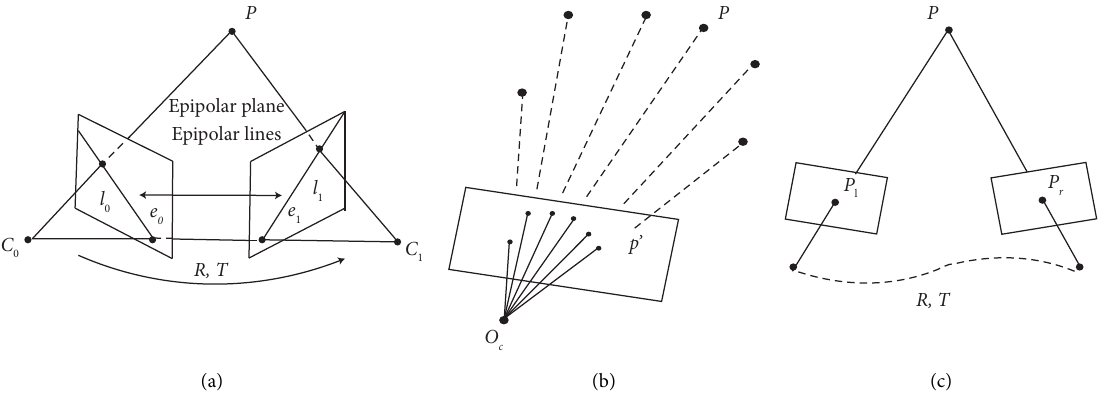
Figure 12: (a) 2D-2D schematic diagram where C and C are the centers of the two cameras, p is a point in space, and the projection of P on 0 1 the corresponding image plane of C and C is X and X , respectively. Te intersections of C and C and the image plane e and e are 0 1 0 1 0 1 0 1 and l are called polar lines, and the plane composed of C , C , and P is called the polar plane. (b) 3D-2D schematic diagram, called poles, l 0 1 0 1 the coordinate of which is P in the world coordinate system, and the pixel coordinate of which is projected into the image is p . (c) 3D-3D schematic diagram, where P l is the coordinate in camera coordinate system and P r is the coordinate in camera coordinate system. Te relative pose relation of the coordinate system is described by R and T